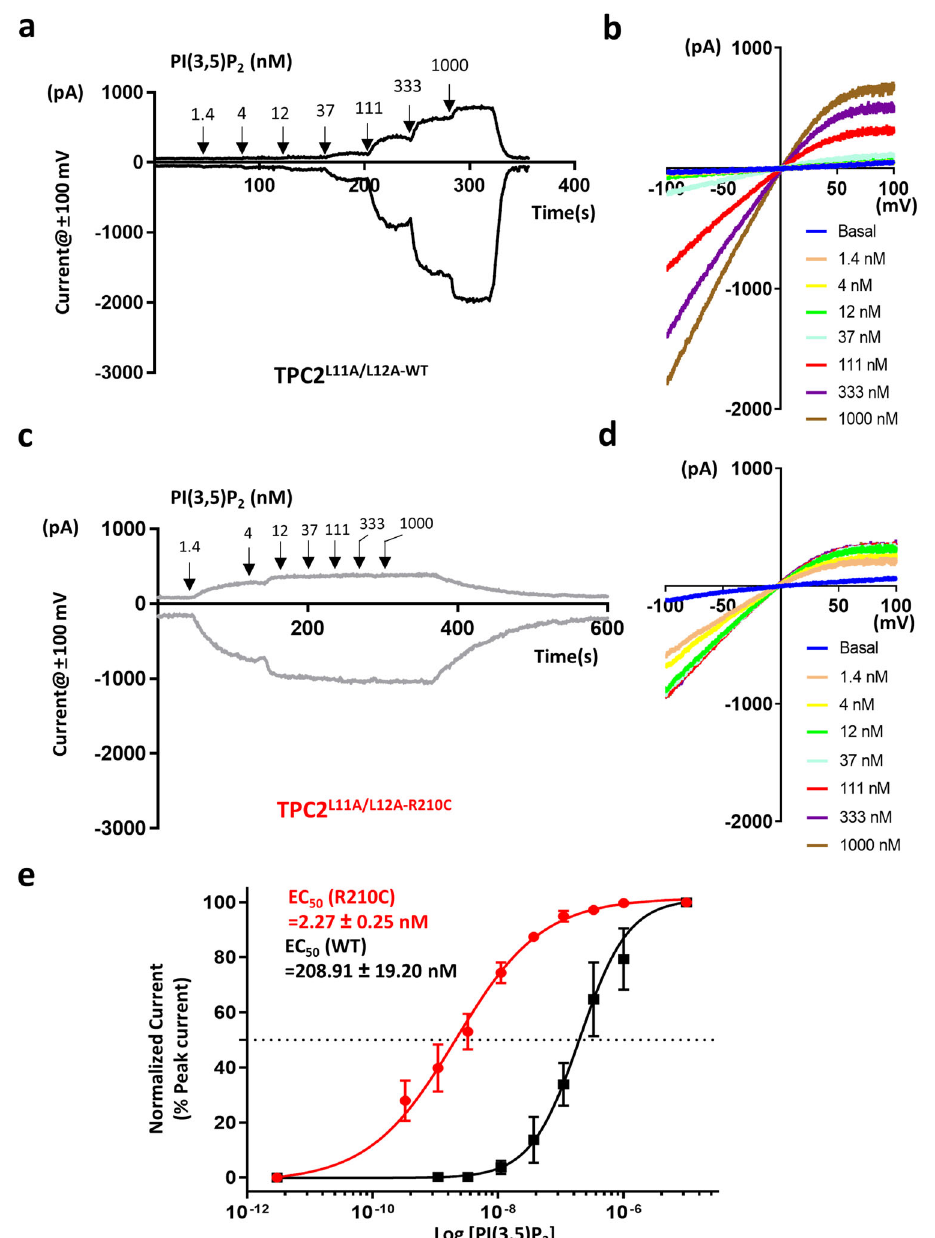
Fig. 3 | TPC2 R210C exhibits increased apparent af fi nity to PI(3,5)P 2 . a Representative traces of TPC2 L11A/L12A-WT currents at ±100mV in response to increasing concentrations of PI(3,5)P 2 -diC8 sequentially applied with a threefold increment at the time points indicated by arrows. b I-V relationships at the steady states corresponding to a for currents evoked by the indicated concentrations of PI(3,5)P 2 -diC8. c Representative traces of TPC2 L11A/L12A-R210C currents at ±100mV in response to the same concentration gradient of PI(3,5)P 2 -diC8 as in a . Note that